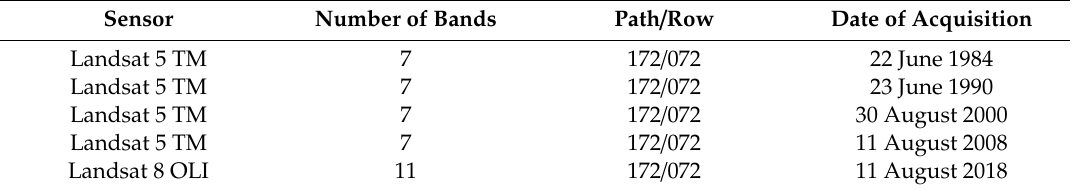
Table 1. The Data used for land use and land cover (LULC) classification and their date of acquisition.